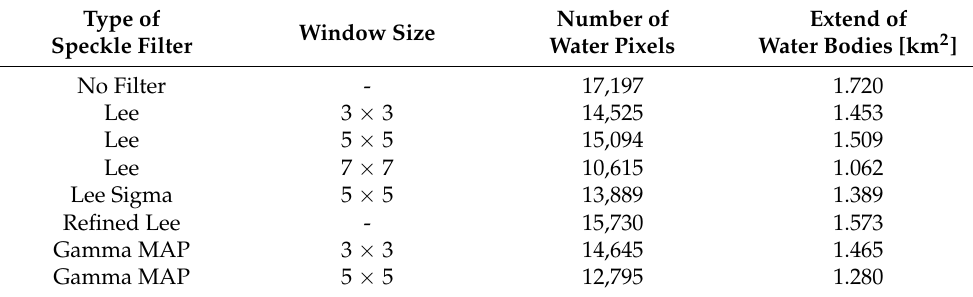
Table 5. Results of the extent of water surfaces during the inundation in the selected Locality 3. Type of Speckle Filter